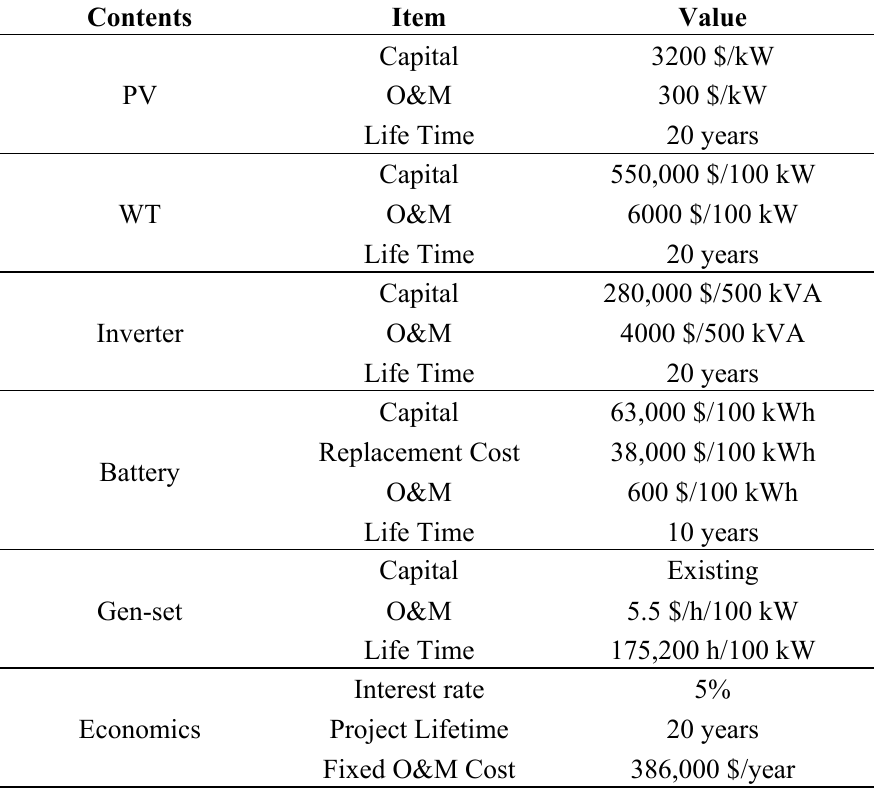
Figure A3. Annual Load Profile of Test Island (2013) [26]. Table A1. Economic Feasibility Study Input Data